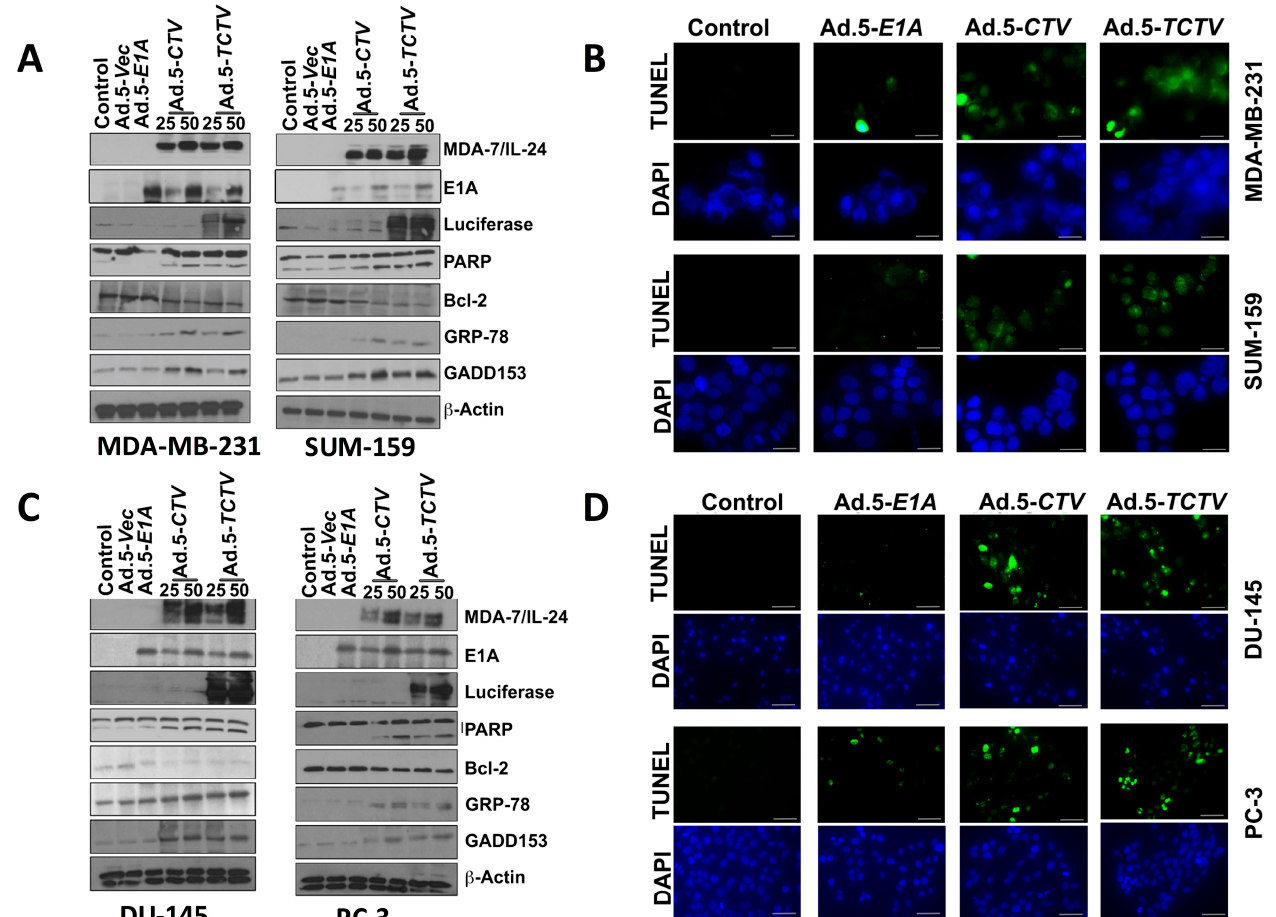
Figure 3. Ad.5- TCTV induces ER stress and apoptosis in cancer cells. ( A ) Breast cancer cells (MDA-MB-231 and SUM-159) treated with 25 pfu of Ad.5- E1A or the indicated pfu of Ad.5- CTV or Ad.5- TCTV for 72 h. Cells were then collected and Western blotting analysis was performed for signaling molecules using specific antibodies and β -actin served as a loading control. ( B ) Breast cancer cells were cultured in 8-well chamber slides and infected with 25 pfu of Ad.5- E1A , Ad.5- CTV, or Ad.5- TCTV for 72 h. Cells were fixed and TUNEL assays were performed. Data presented as TUNEL positive cells in a defined microscopic field as compared with un-treated control cells. ( C ) Prostate cancer cells (DU-145 and PC-3) were treated as described in A , cells were then collected and Western blotting analysis was performed for signaling molecules using specific antibodies and β -actin served as a loading control. ( D ) Prostate cancer cells were treated as described in B and cells were fixed and TUNEL assays were performed. Data presented as TUNEL positive cells in a defined microscopic field as compared with un-treated control cells. Scale bar: 200 μ M.